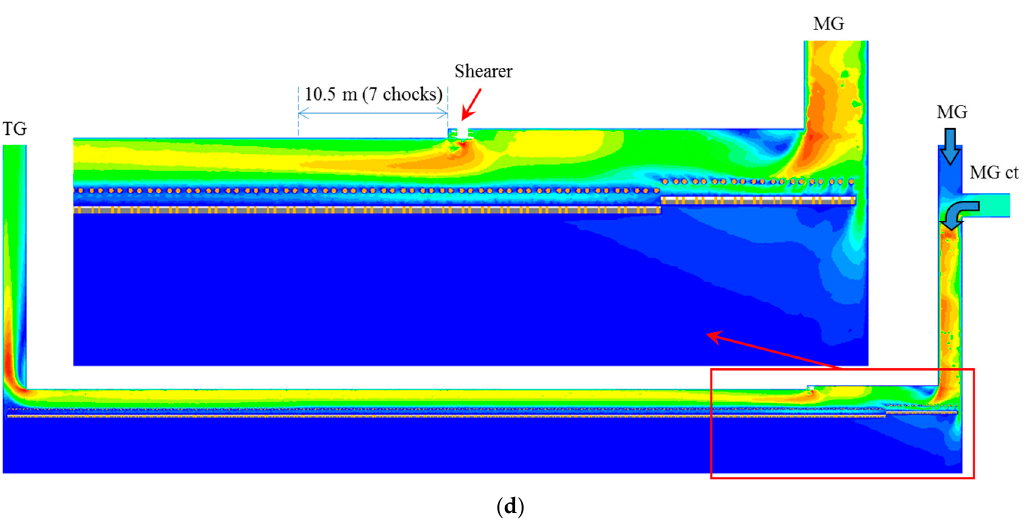
Figure 5. Velocity contour at different levels above floor: ( a ) 1.5 m above floor (near the top of the shearer); ( b ) 2 m above floor; ( c ) 2.5 m above floor; ( d ) 3 m above floor.